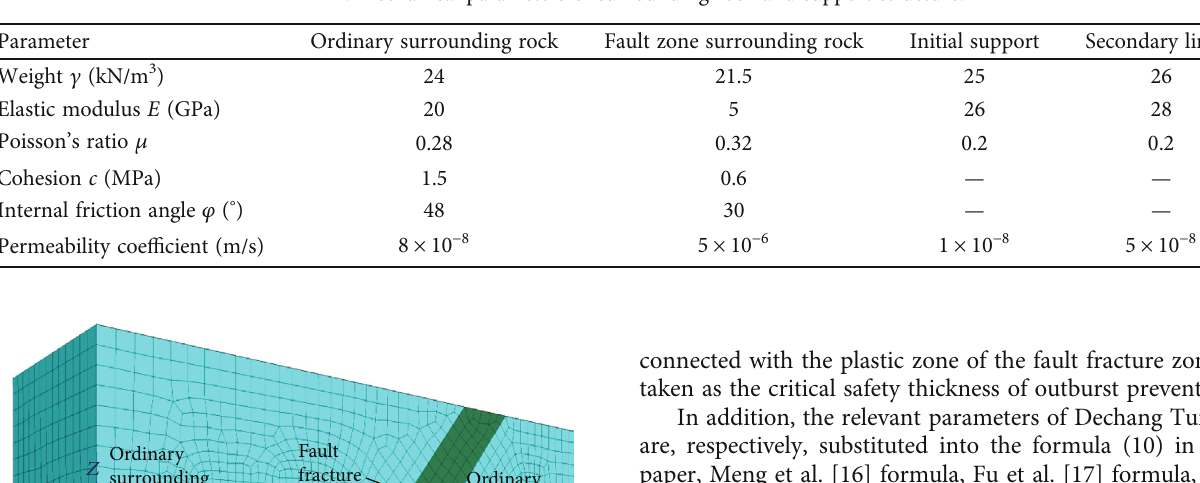
Figure 6: The geological section of Gaojiawan fault fracture zone. Table 1: Mechanical parameters of surrounding rock and support structure.